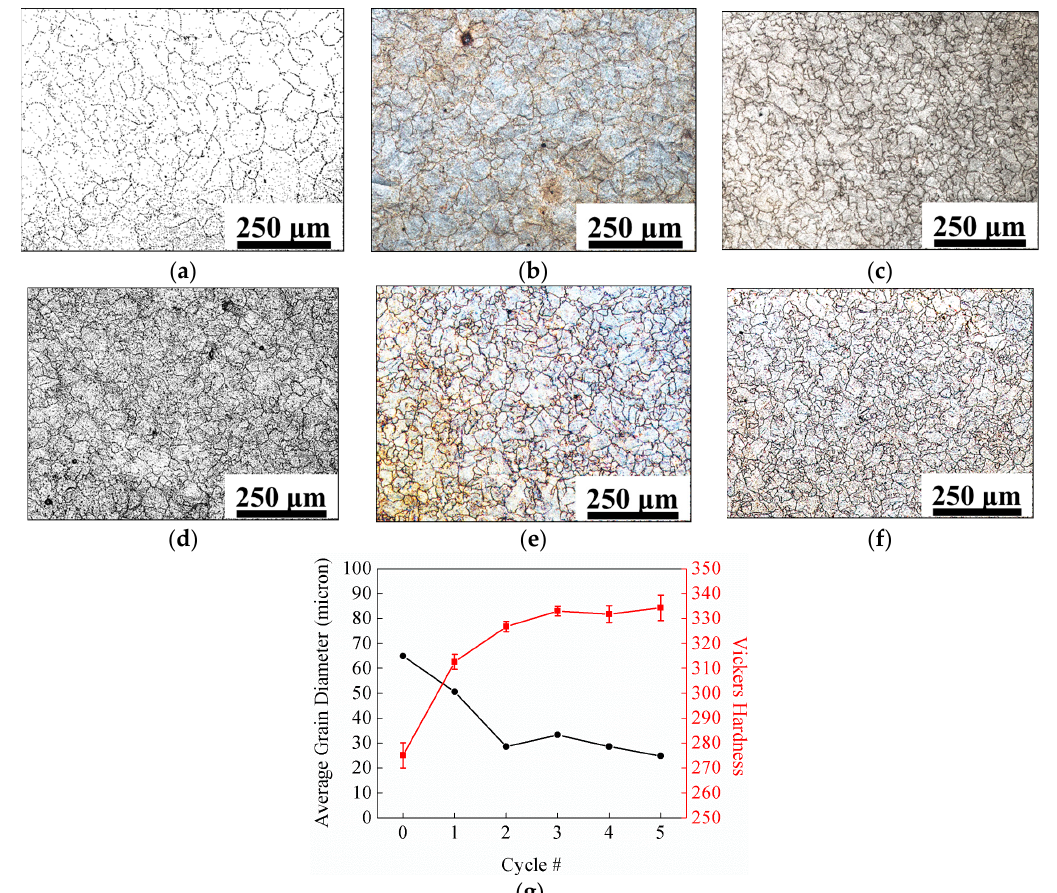
Figure 8. Grain structure of DED PH48S after cyclic austenitizing. ( a – g ) Grain morphologies: ( a ) as-homogenized (0 cycle); ( b ) 1 cycle; ( c ) 2 cycles; ( d ) 3 cycles; ( e ) 4 cycles and ( f ) 5 cycles; ( g ) Grain size and microhardness vs. cycles of austenitizing. Adapted from Yan [31].